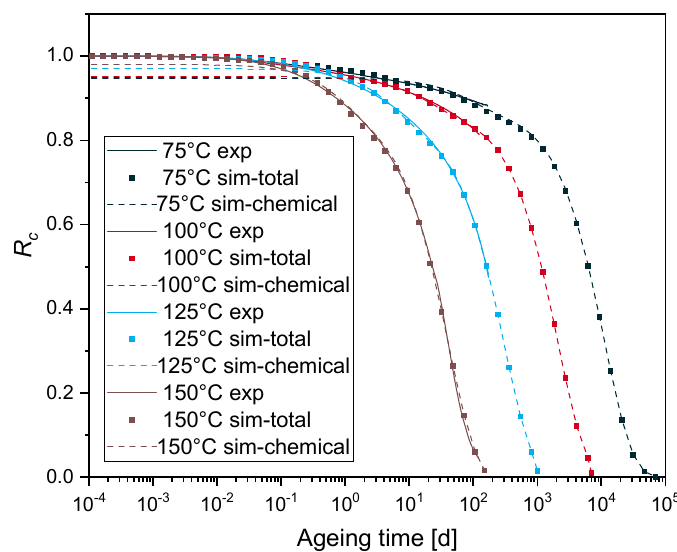
Figure 8. Normalized continuous stress relaxation for EPDM aged at 75 °C, 100 °C, 125 °C and 150 °C